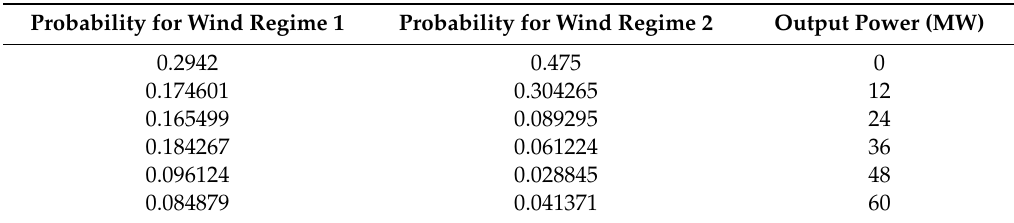
Table 5. Sixty-megawatt wind farm output power model for two wind regimes.